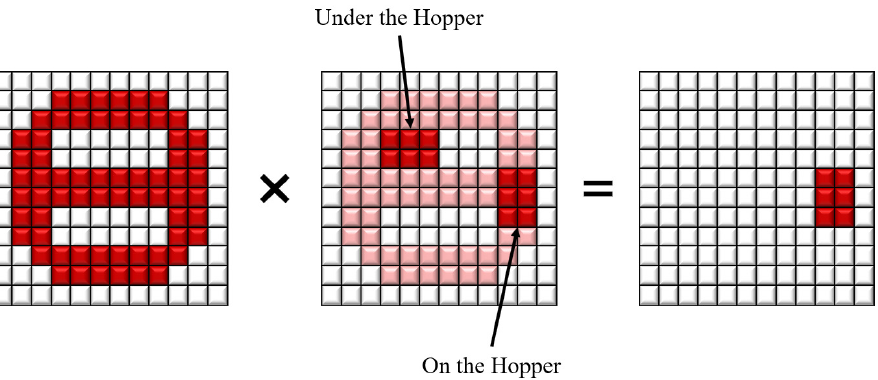
Figure 8. Detection of target objects on the hopper’s boundary using RGB and depth